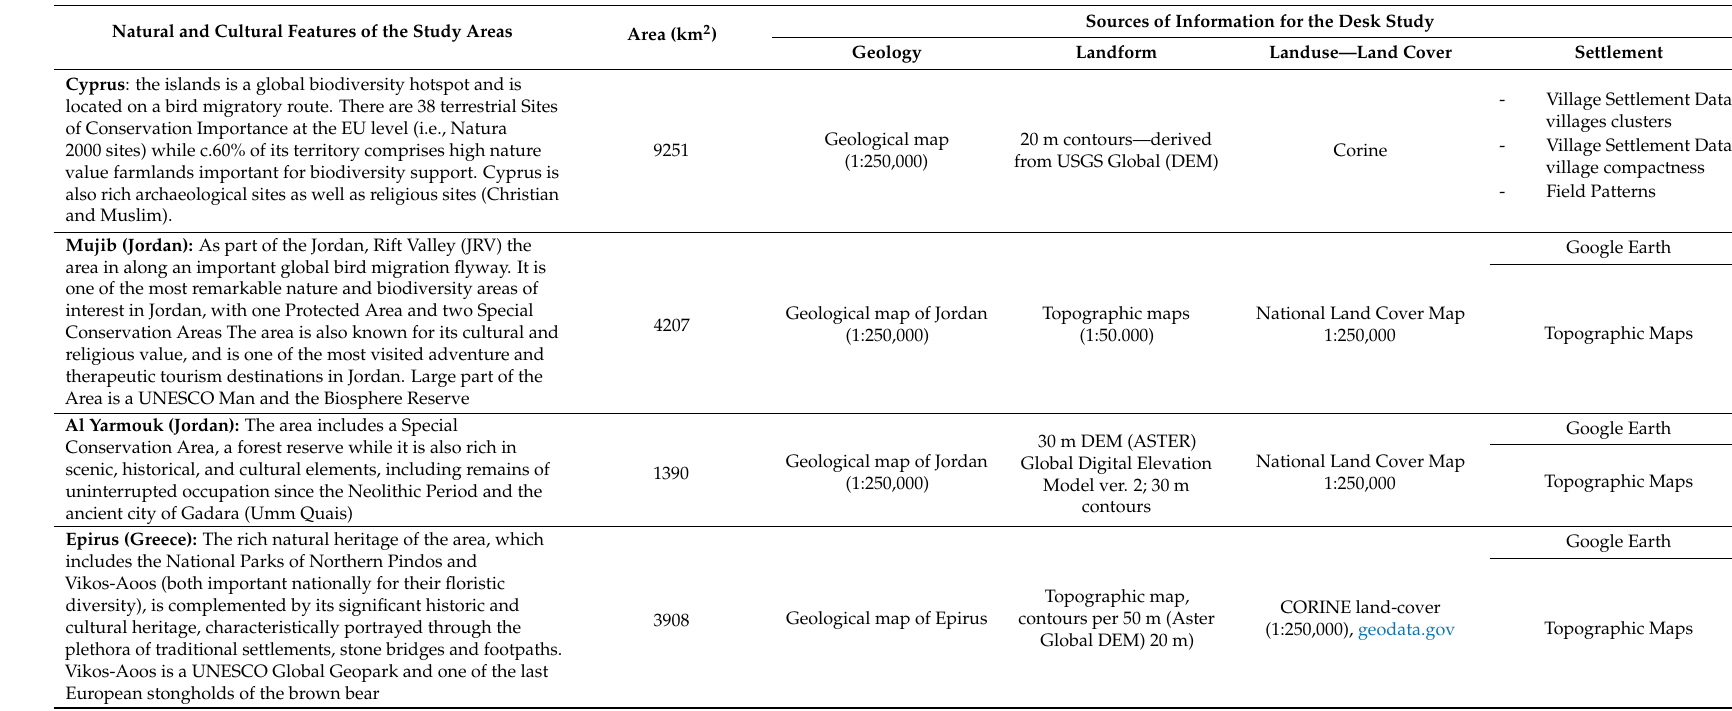
Table 1. Main characteristics of the study sites and the datasets used in Landscape Character